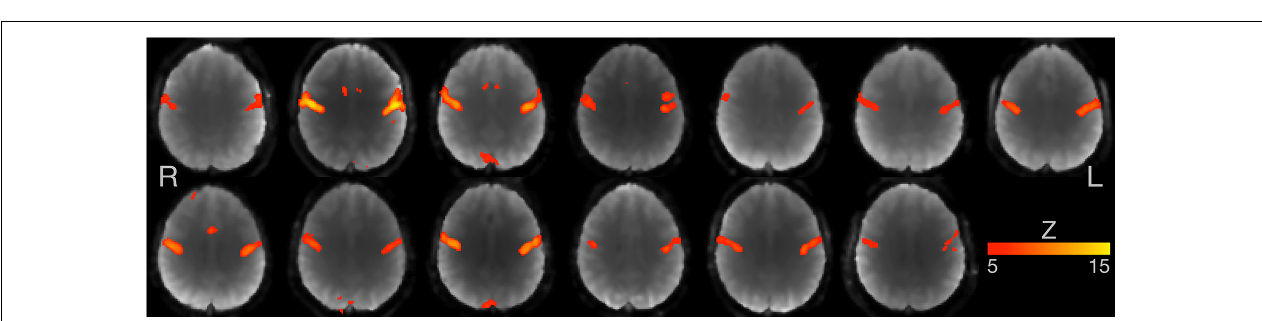
FIGURE 3 | Individual FMRI results based on voxel-wise multiple linear regressions. Axial slices for all 13 participants are shown at the level of maximum activity in the primary sensorimotor cortex. Images are in radiological convention (the left hemisphere is seen on the right). Z -value ≥